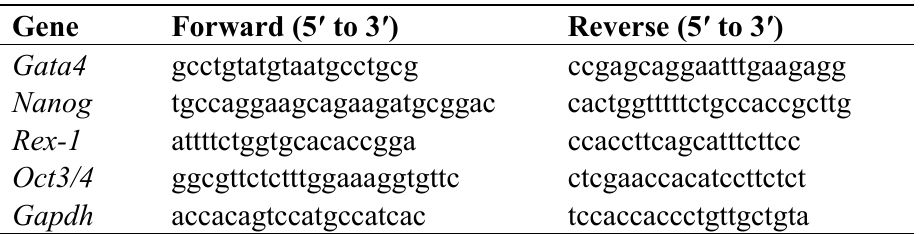
Table 1. Primers used for RT-PCR